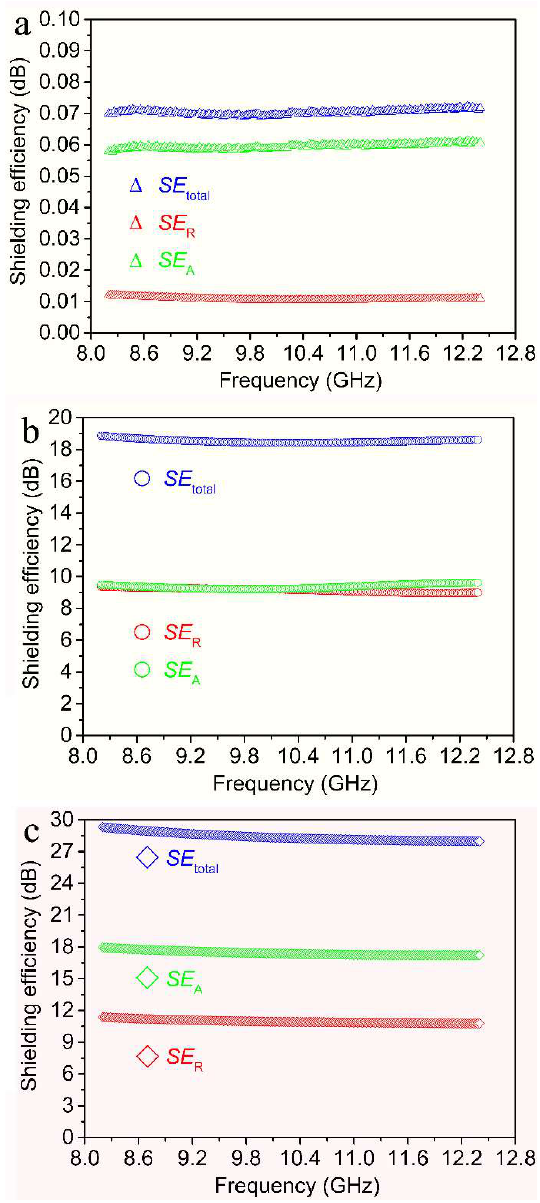
Figure 6. EMI shielding effectiveness (including SE total , SE R and SE A ) of ( a ) the cotton fibers, ( b ) CDCFs and ( c ) nano-Cu/CDCFs, respectively.